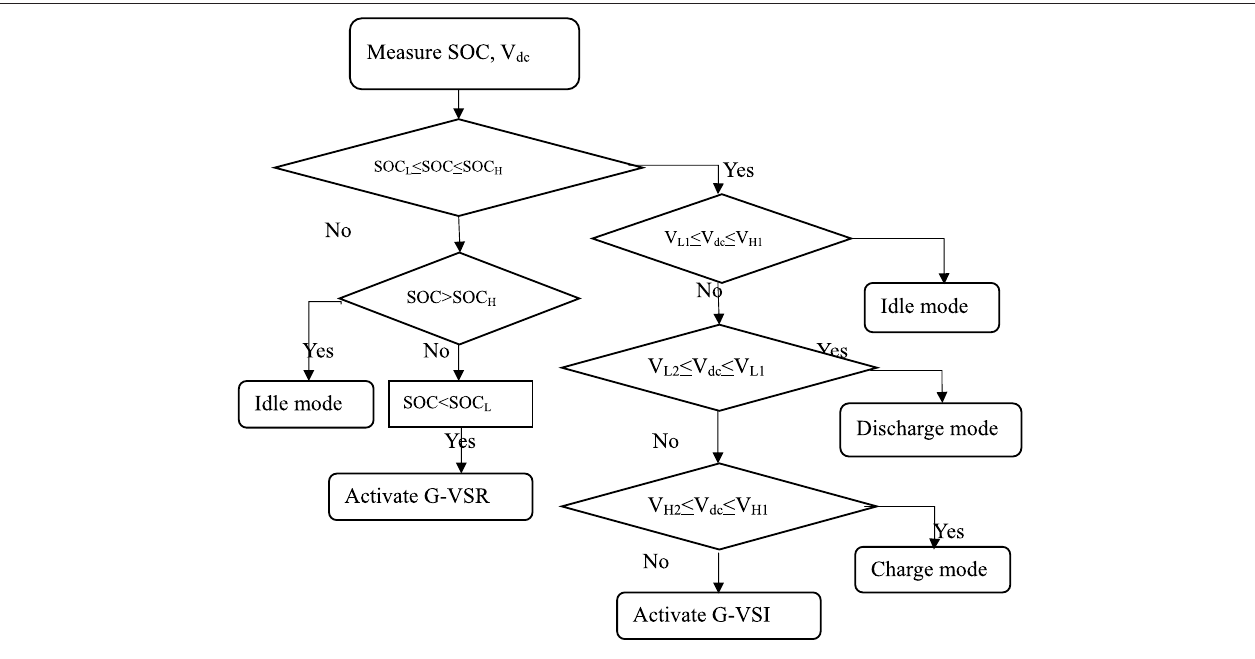
FIGURE 6 | Flow chart for Power management using fuzzy logic controller.